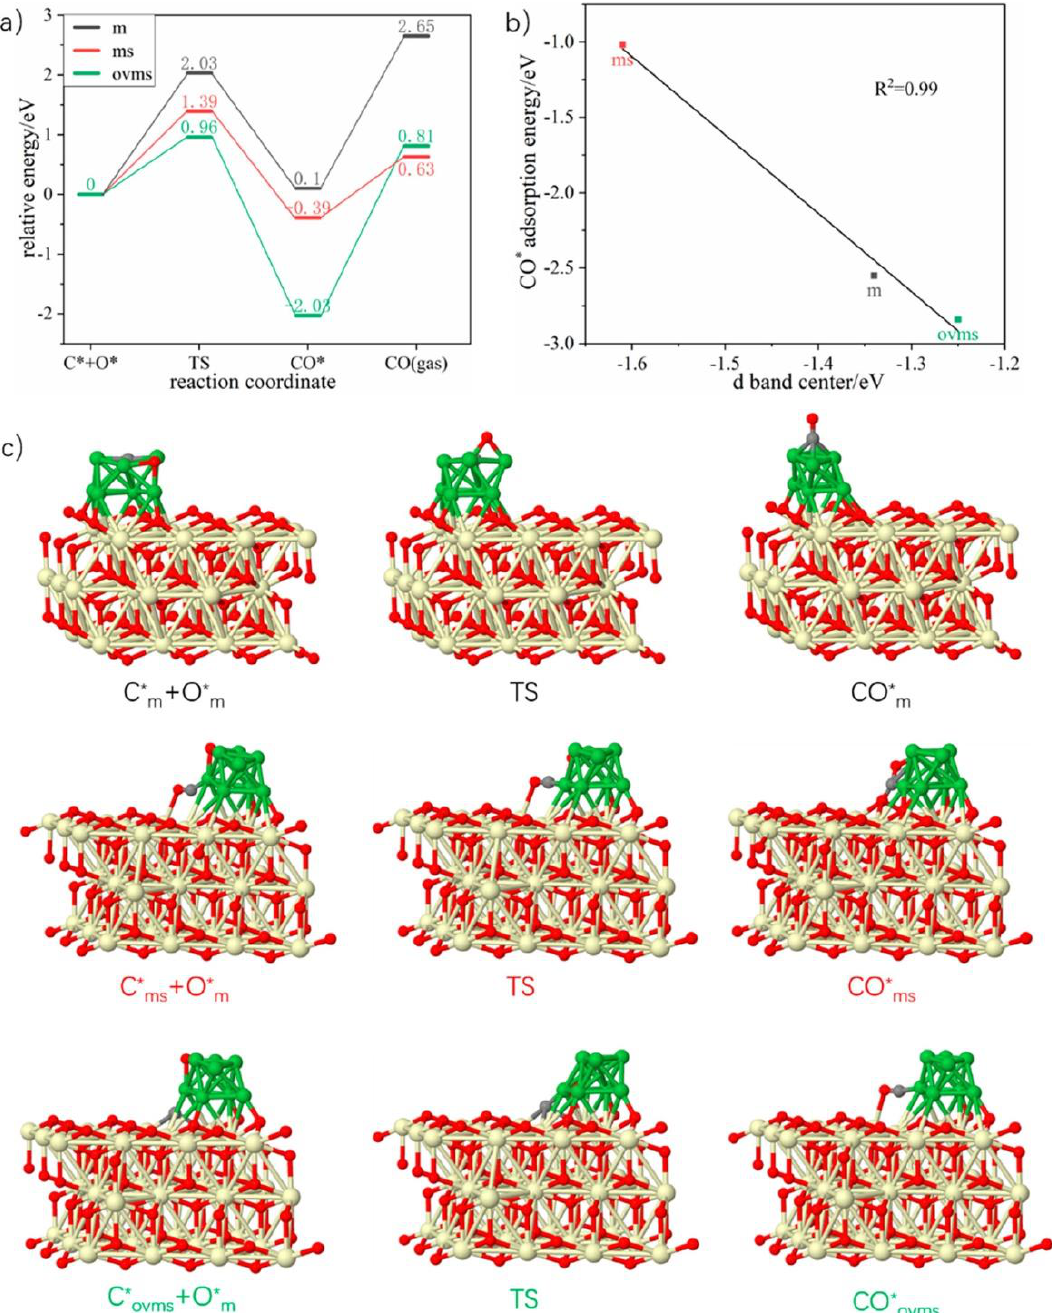
Figure 2. Three paths of C* elimination. ( a ) Relative energy of C* elimination at m, ms, and ovms sites. ( b ) Relation of d band center with CO* adsorption energy. ( c ) Corresponding configurations of part a. Gray spheres represent C, red spheres represent O, green spheres represent Ni and cream-colored spheres represent Ce. Reproduced with permission from reference [58].